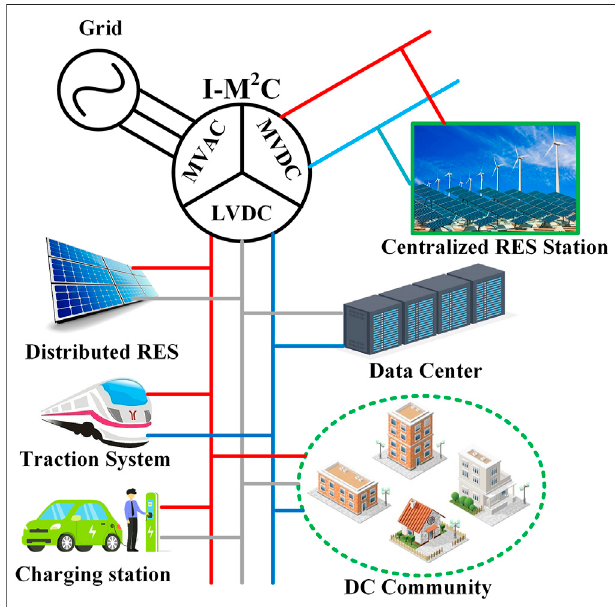
FIGURE 2 | Example of the I-M 2 C in the urban power